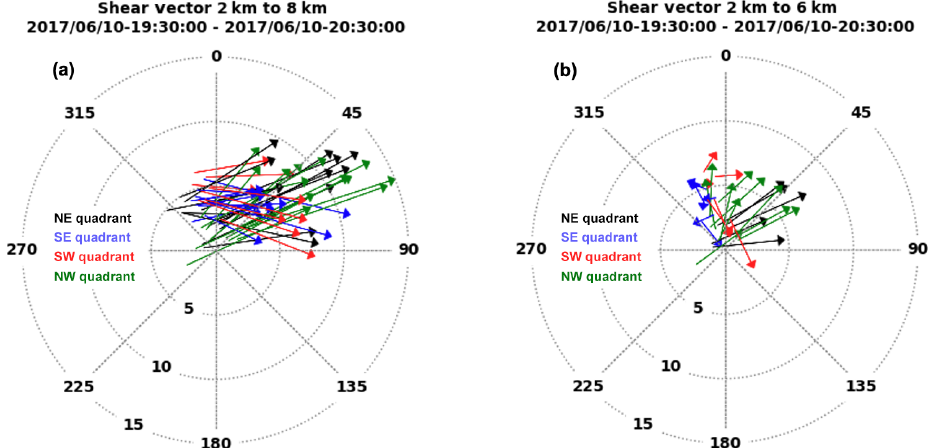
Figure 11. Same as Fig. 7, but for flight segment 2